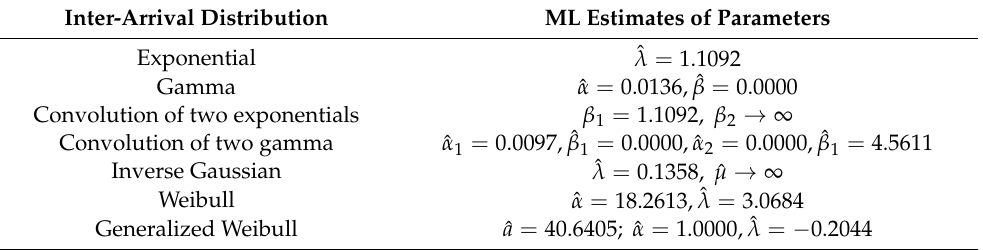
Table 7. ML estimates of the fitted